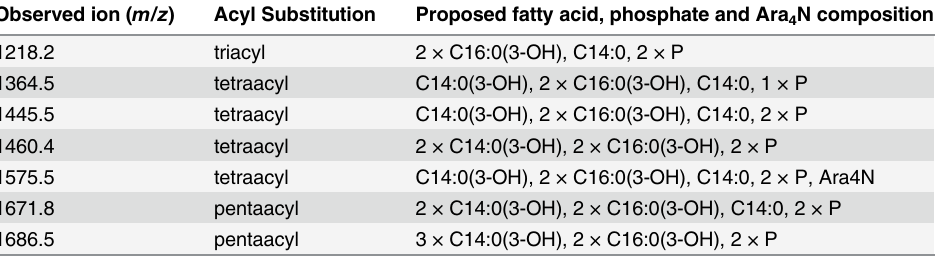
Lipid A of B . pseudomallei 1026b was analyzed by negative-ion MALDI-TOF-MS. Several negative-ion peaks were found and interpreted. Several peaks corresponding to single-charged lipid A ions were found and interpreted by comparison with calculated m/z values of variously substituted species of lipid A shown in S2 Fig. Complex pattern of molecular ion peaks indicative of a heterogeneous mixture of species is often observed in MS spectra of lipid A isolated from bacterial LPS, for example B . pseudomallei , B . thailandensis [16] and B . Mallei [20]. (m/z) = mass-to-charge